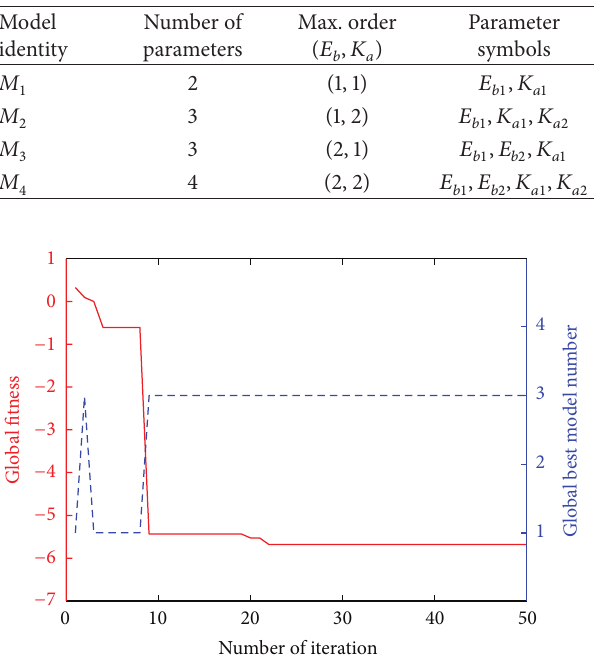
Figure 15: Global fitness and global best model number during